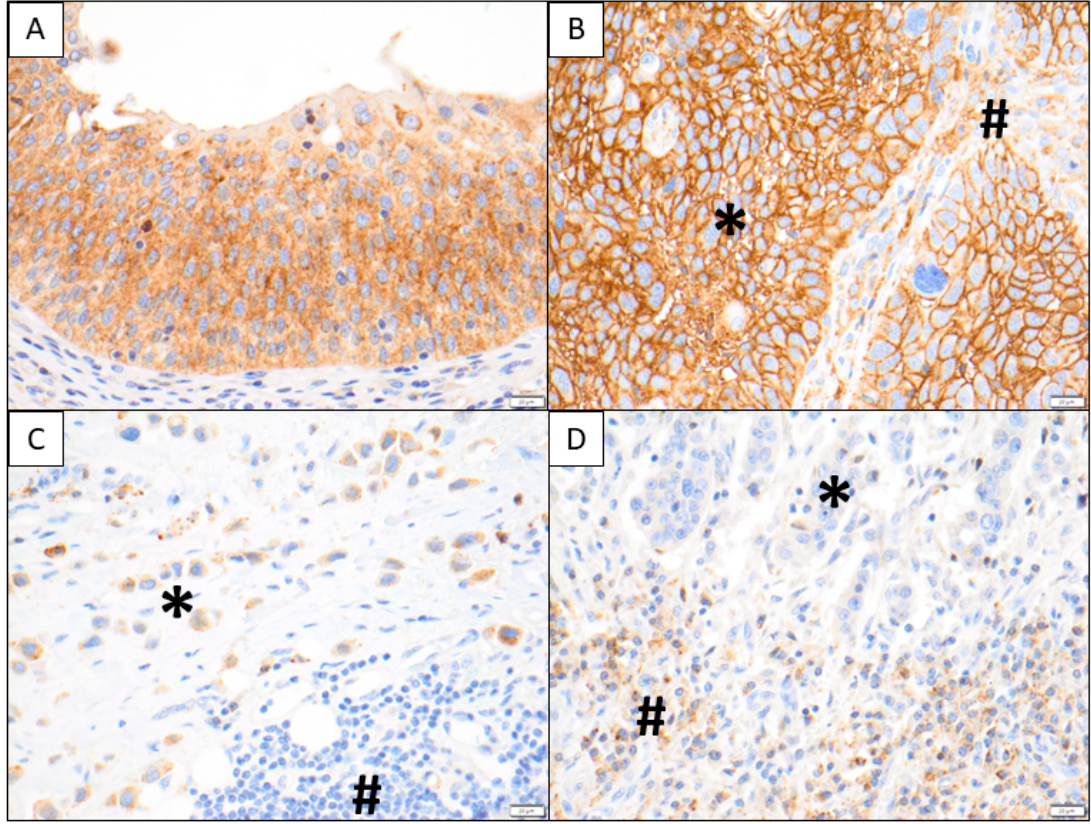
Figure 1. In ( A ), typical SDC1 staining is shown in non ‐ neoplastic urothelium including intra ‐ epithelial lymphocytes. In ( B ), strong tumoral membranous and cytoplasmic SDC1 immunoreactivity is depicted (*), while stromal elements exhibit a weak to moderate SDC1 immunoreactivity (#). In contrast, a plasmacytoid urothelial carcinoma shows weak to moderate SDC1 staining (#) in ( C ), while the stromal components and lymphocytes are SDC1 negative (#). In ( D ), only very faint SDC1 tumor cell reactivity is visible (*) and the plasma cells at the tumor–stroma interface show moderate to strong granular cytoplasmic SDC1 positivity (#).